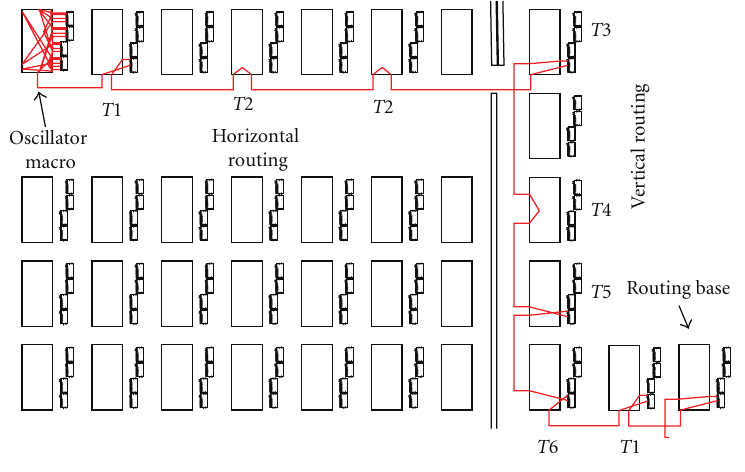
Figure 9: Zoom of online routing